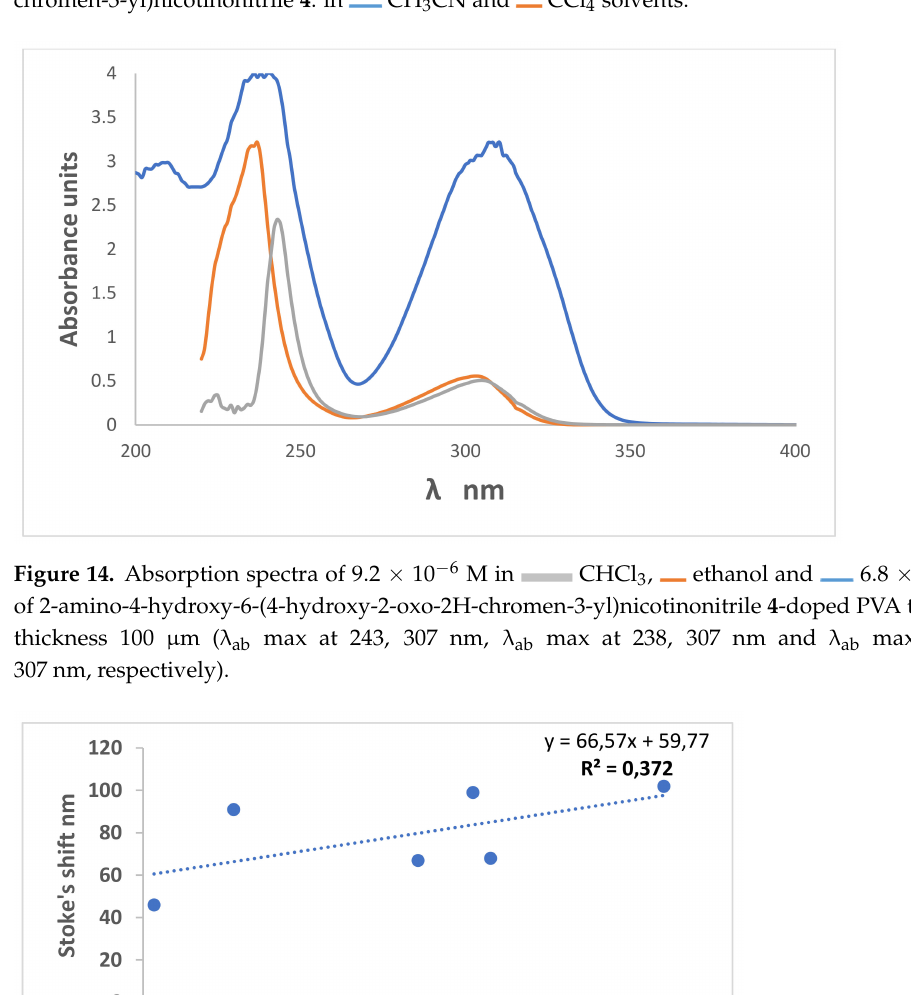
Figure 13. Absorption spectra of 9.2 × 10 − 6 M of 2-amino-4-hydroxy-6-(4-hydroxy-2-oxo-2H- chromen-3-yl)nicotinonitrile 4 . in CH 3 CN and CCl 4 solvents.